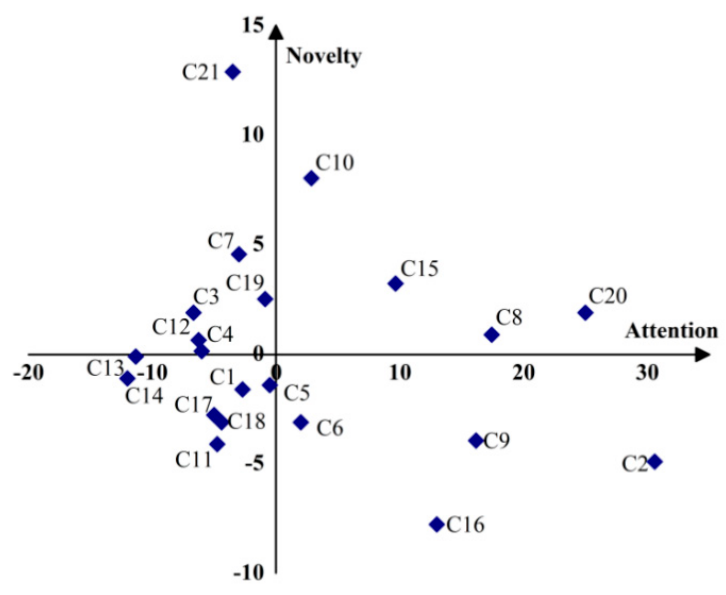
Figure 5. Strategic diagram of health technology research